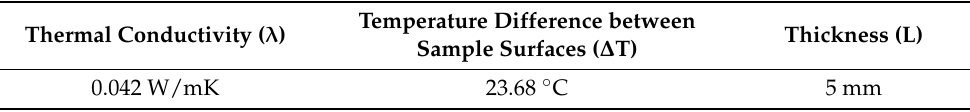
Table 4. Variables for measuring the conduction heat flow for the EPS